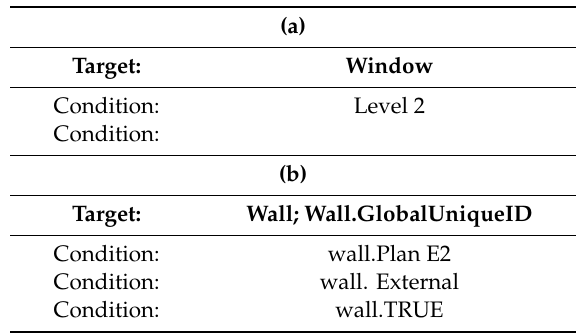
Table 1. The format of query